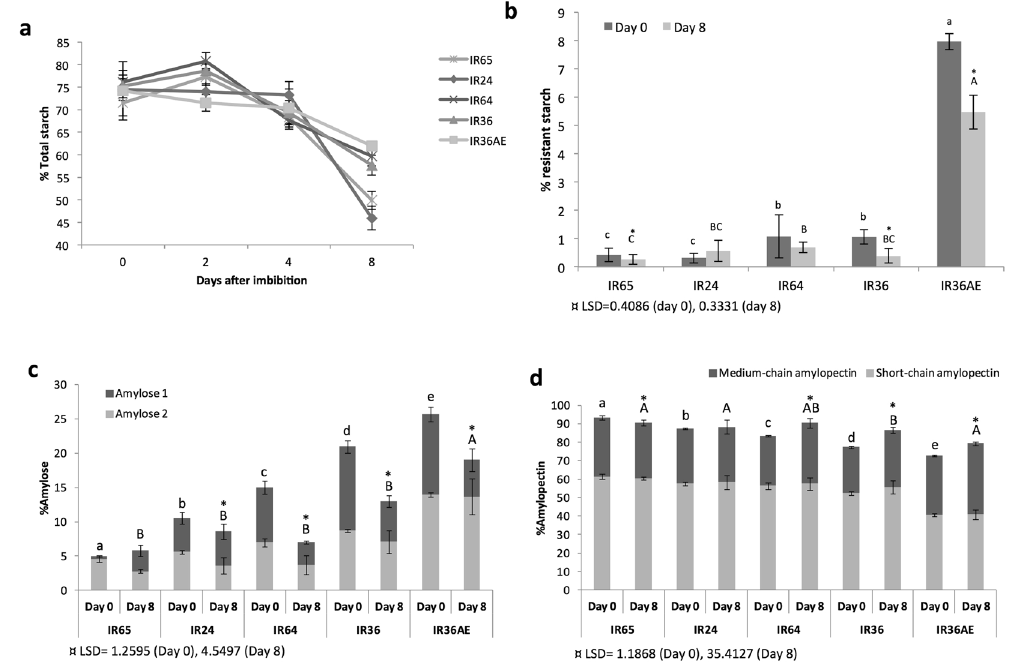
Figure 3. Mobilization of starch during germination. Amounts of ( a ) total starch and ( b ) resistant starch in the germinated grain. The changes in the ( c ) amylose and ( d ) amylopectin fractions are shown. Each fraction is calculated based on 100% starch. Values represent the mean ± SD of 3 biological replicates. In each time point, means with the same letter are not significantly different based on pairwise mean comparison of variance through LSD (least significant difference) test. Values of test statistics are indicated by ¤. Means with * are significantly different compared to day 0 (P <